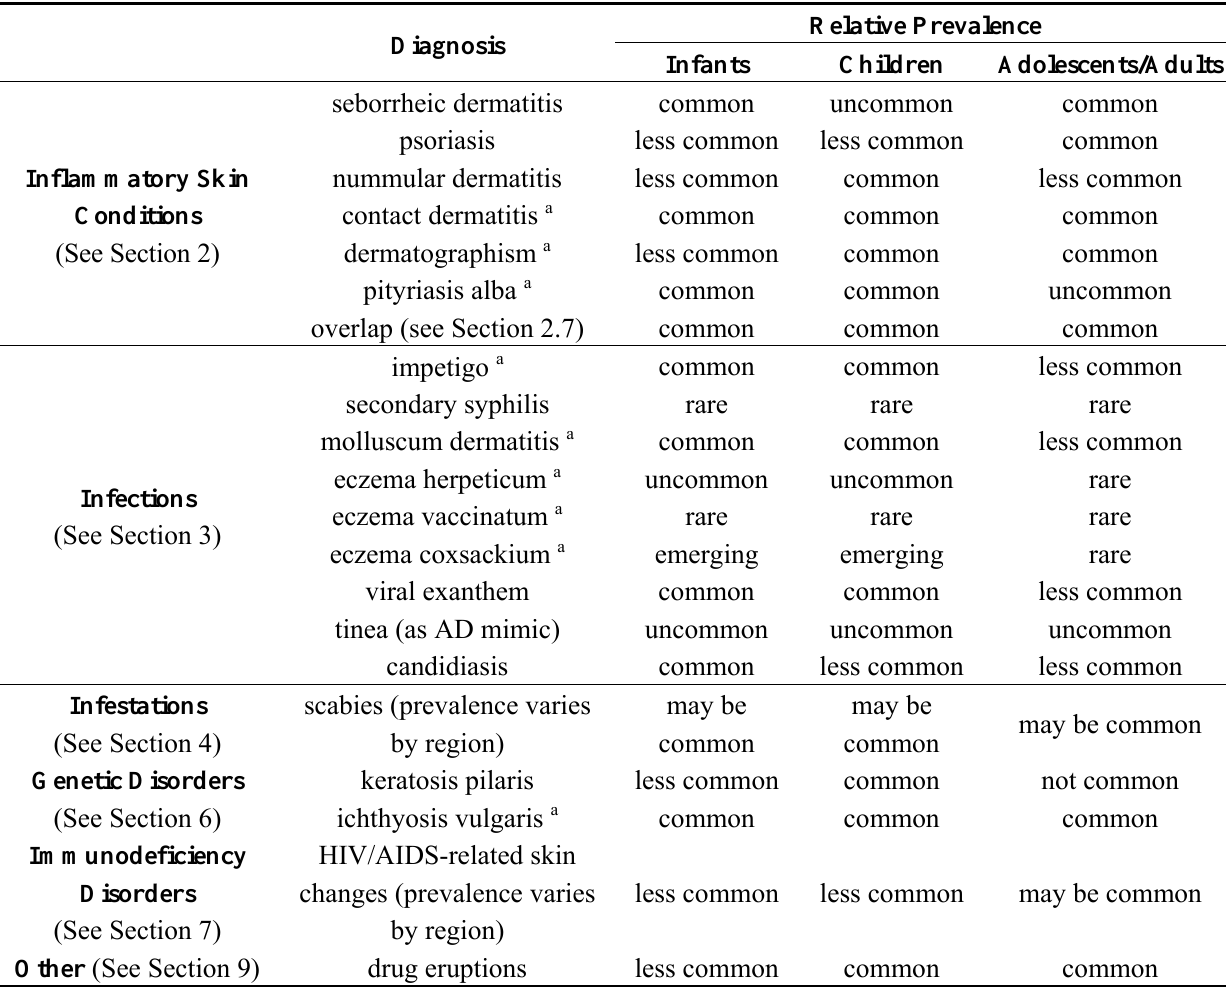
Table 2. Diagnosis of atopic dermatitis: common mimics, overlaps, and complications and relative prevalence by age